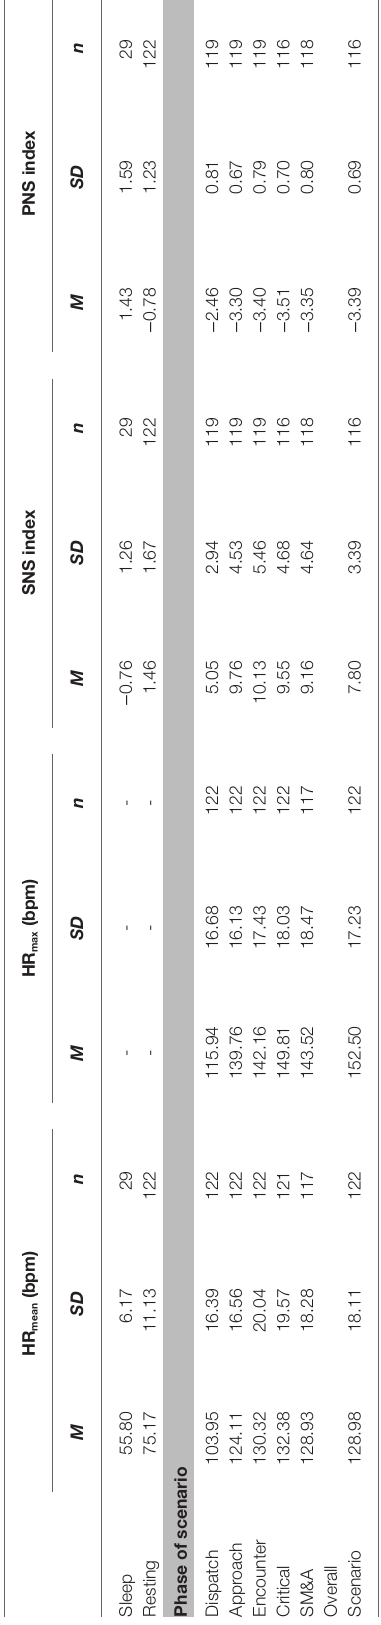
Figure 2 for a line chart of SNS and PNS index values during sleep, while at rest, and during the phases of the